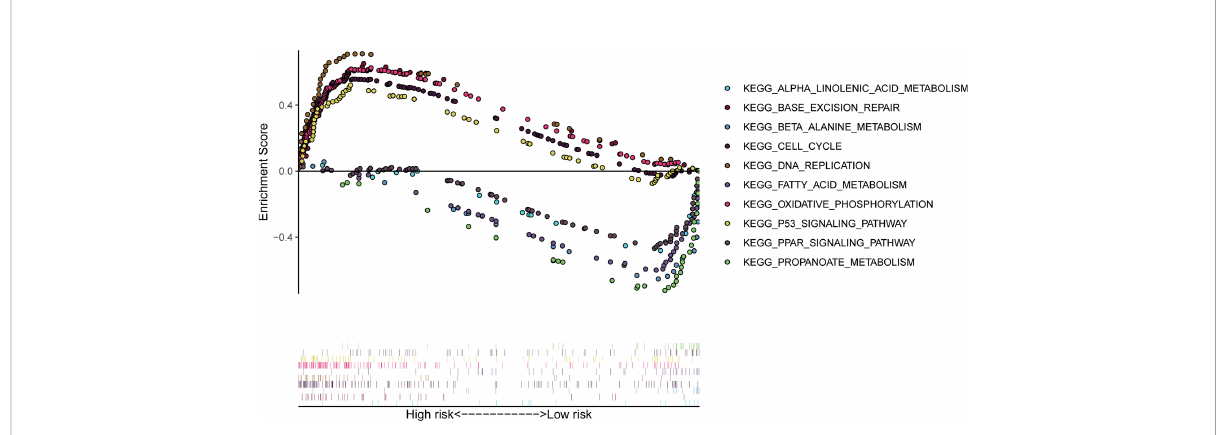
FIGURE 7 GSEA signi fi cantly enriched the KEGG pathway in the TCGA cohort. Above the horizontal axis indicates pathways in the high-risk group and below the horizontal axis indicates pathways in the low-risk